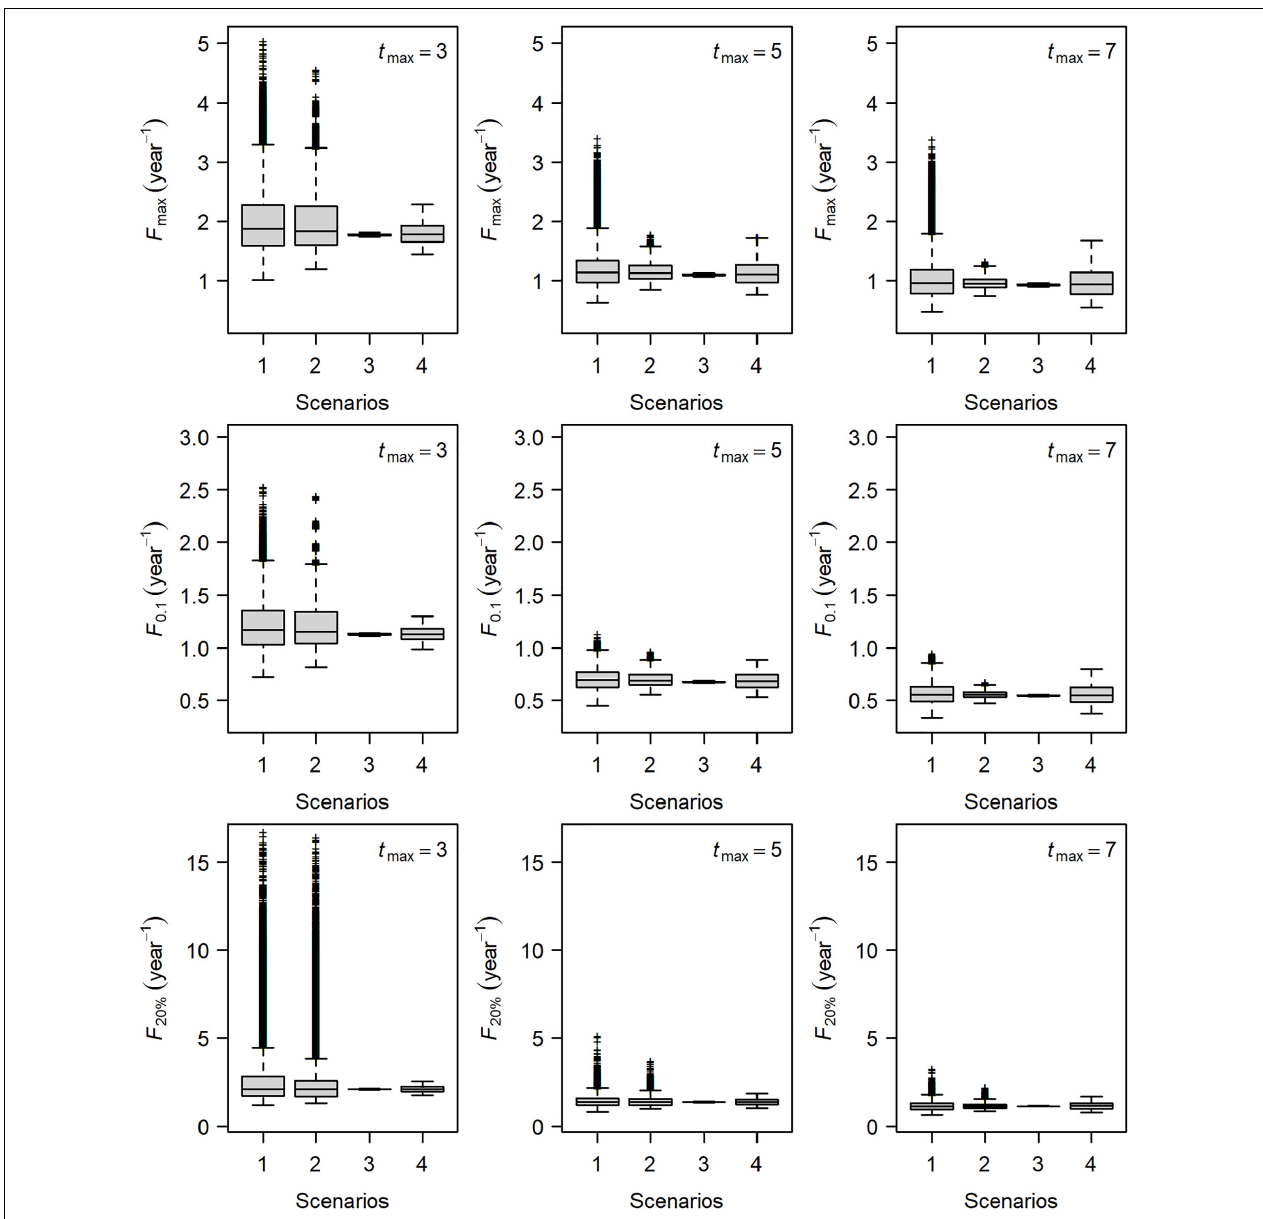
FIGURE 3 | Boxplot of biological reference points F max , F 0 . 1 , and F 20% in four scenarios for Group 1 of small yellow croakers. Scenario 1 denoted the variation in all types of life history parameters. Scenarios 2, 3, and 4 denoted the variation in growth parameters, length–weight relationship parameters, and natural mortality rate,